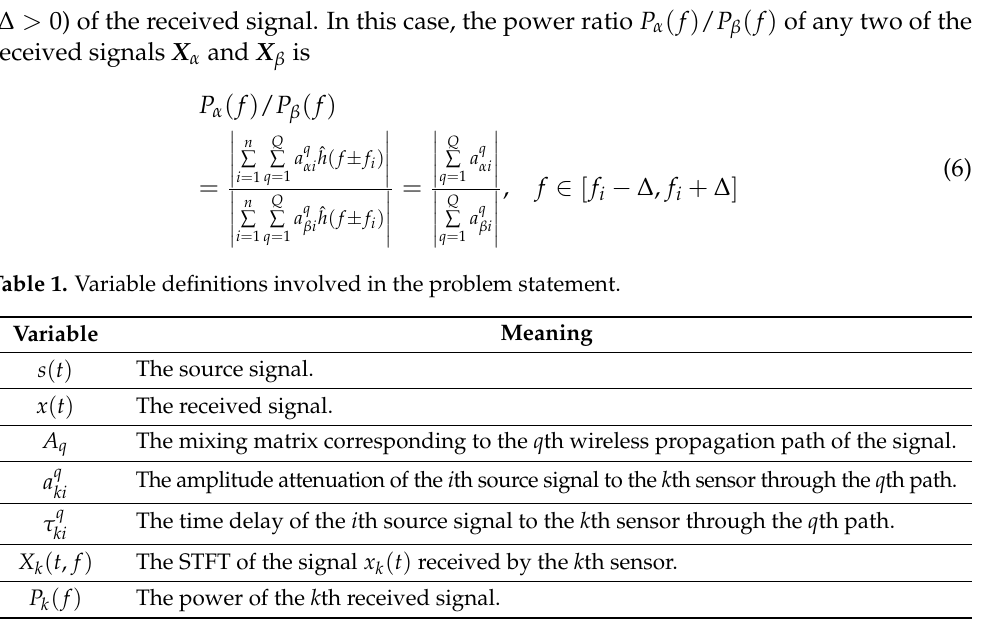
Figure 2. The power scatters of mixed signals with TF aliasing. 3. UBSS Algorithm Based on TF Soft Mask To tackle the above challenge, we propose a new blind separation strategy based on TF soft mask. The process consists of two main stages. The first step is to determine the number of sources through the KDE algorithm, followed by peak detection. After that, the contribution degree of the source signal in the observed signal is calculated by the contri- bution degree function to construct the TF soft mask matrix, which is used to separate the TF aliasing signals. All variables involved in the section are described in Table 2. Table 2. Variable definitions in this section. Variable